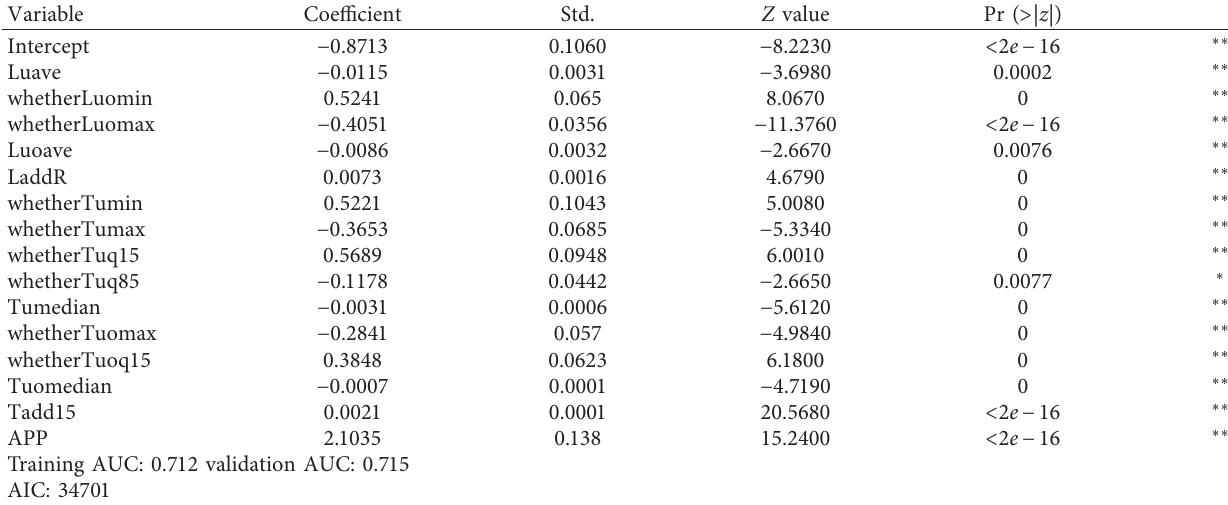
Figure 4: The schematic diagram of the trajectory difference calculation. Table 2: Return demand prediction model.